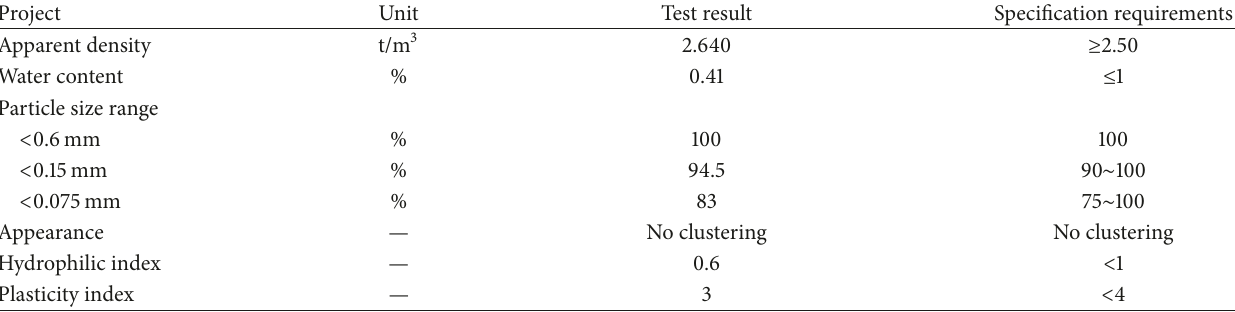
Table 4: Technical indexes of filler.